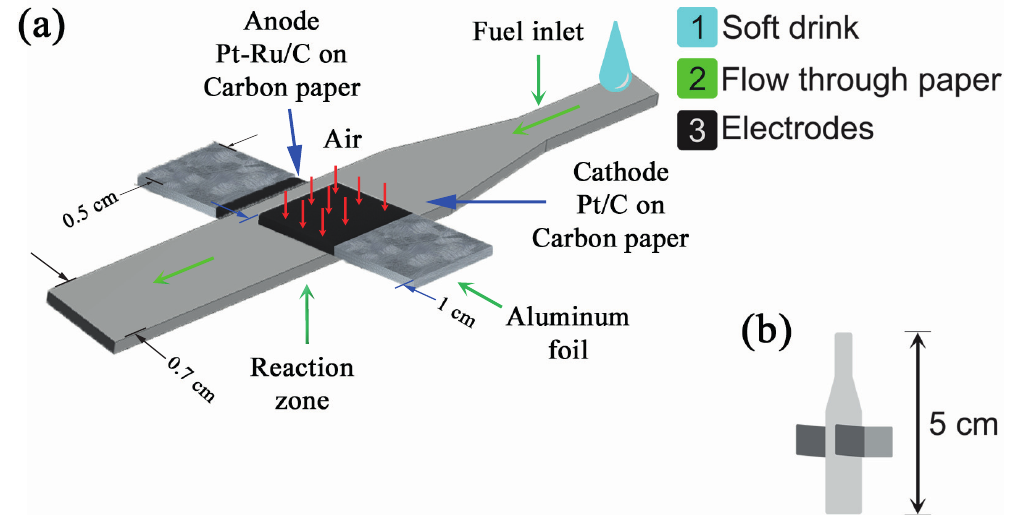
Figure 1. Components of fuel cell: ( a ) Schematic design of the paper-based microfluidic fuel cell and ( b ) dimension of the paper-based microfluidic fuel cell ( µ